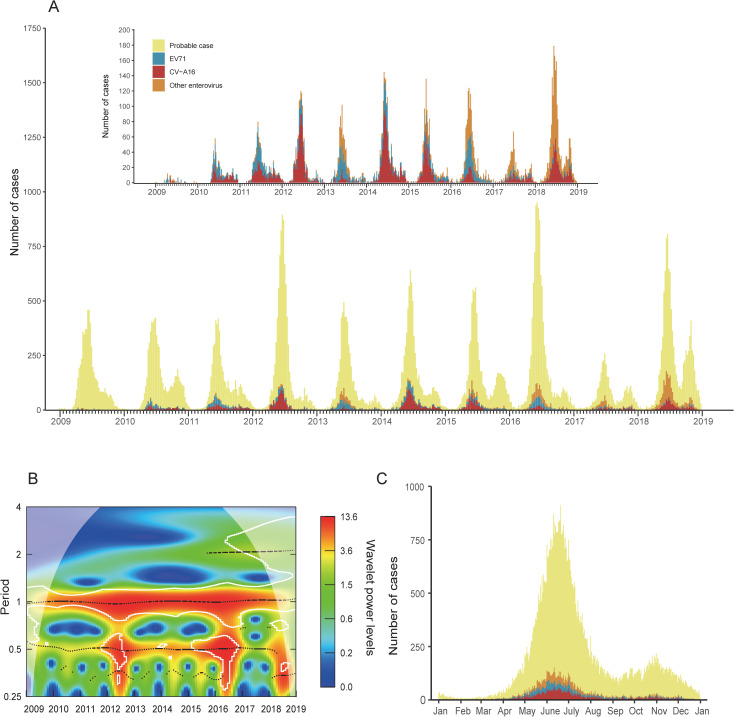
Epidemiology of hand foot and mouth disease (HFMD) in Xinjiang Uighur Autonomous Region during 2009–2018.(A) Weekly changes in HFMD incidence. (B) The periodicity of HFMD summarized by wavelet analysis. (C) Epidemical curve in the annual scale.